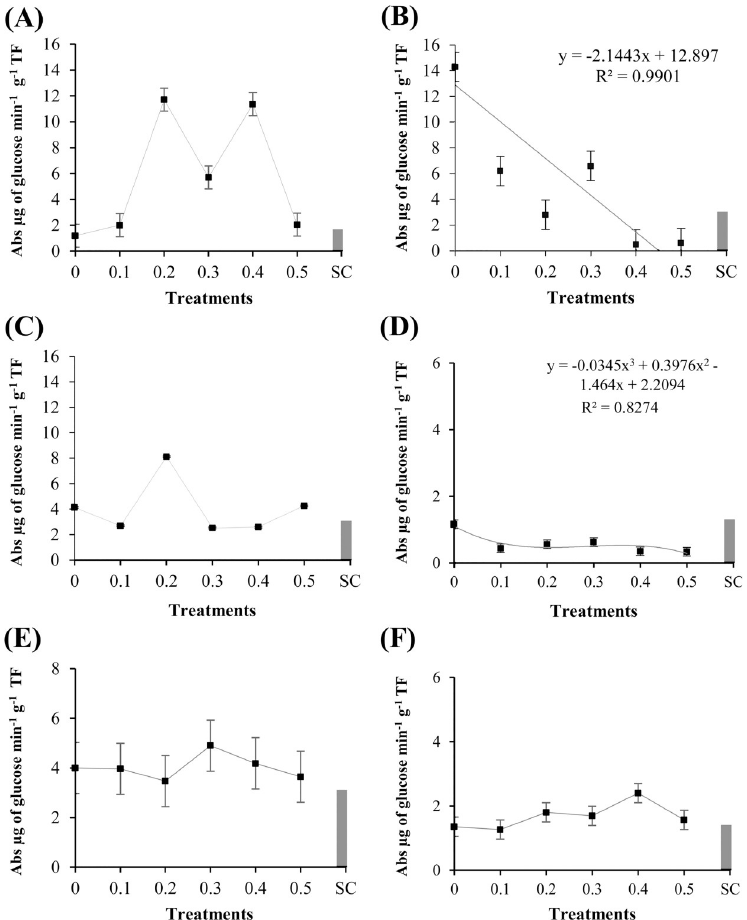
(0), and S . cerevisiae (SC). Cultivars treated with the extract of R . guttatus cutaneous secretions (species 1): ( A ) ‘Monsoy 8372 IPRO’; ( B ) ‘TMG 132 RR’; and ( C ) nontransgenic ‘TMG 4182’. Cultivars treated with the extract of R . marina cutaneous secretions (species 2): ( D ) ‘Monsoy 8372 IPRO’; ( E ) ‘TMG 132 RR’; and ( F ) nontransgenic ‘TMG 4182’. Data are the mean of three independent experiments. Data when significant were subjected to regression analysis (P � 0.05), adjusting the regression equations (R 2 ). Treatment with S . cerevisiae was used as an additional control. Metric bars indicate the standard error of the mean